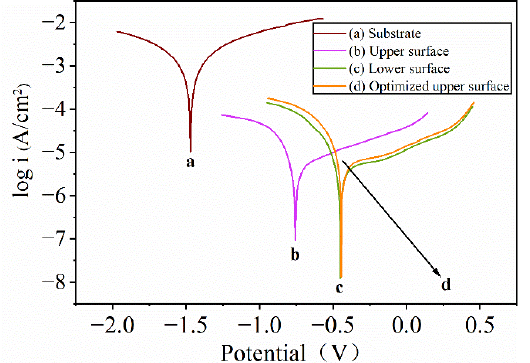
Figure 7. Potentiodynamic polarization curves of substrate, the upper and lower surfaces of Ni–P coating on magnesium–lithium alloy before and after optimization in 3.5 wt% NaCl solution: (curve a) magnesium–lithium alloy substrate; (curve b) upper surface of Ni–P coating before optimization; (curve c) lower surface of Ni–P Coating before optimization; (curve d) upper surface of Ni–P coating after